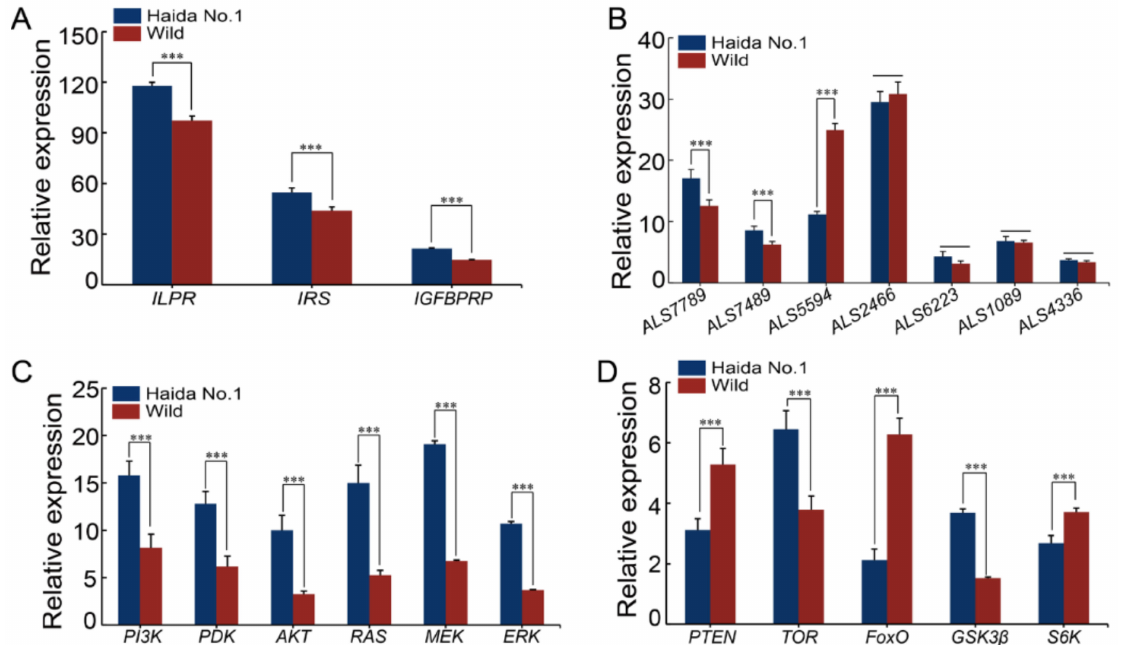
Figure 5. Expression profiles of the IIS, PI3K-AKT, RAS-MAPK, and TOR signaling pathway genes. ( A ) Expression profiles of the ILPR , IRS , and IGFBPRP between the “Haida No.1” and wild oysters. ( B ) Expression profiles of the IGFALS genes between the “Haida No.1” and wild oysters. ( C ) Expression profiles of the PI3K , PDK , AKT , RAS , MEK , and ERK genes between the “Haida No.1” and wild oysters. ( D ) Expression profiles of the PTEN , TOR , FoxO , GSK3 β , and S6K genes between the “Haida No.1” and wild oysters. Data are expressed as the mean ± SD (n = 4). The significant difference among groups is indicated by the asterisk symbol *** ( p <